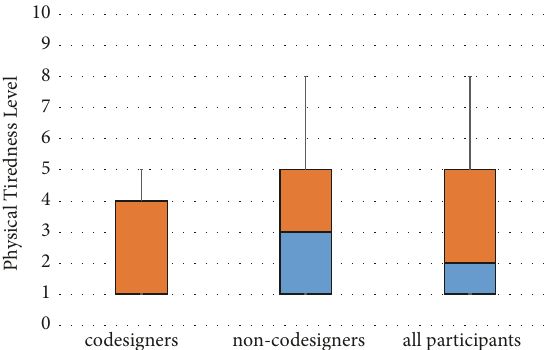
Figure 19: Answers from topic 12 of Table 9: this topic measures physical fatigue after playing the game.